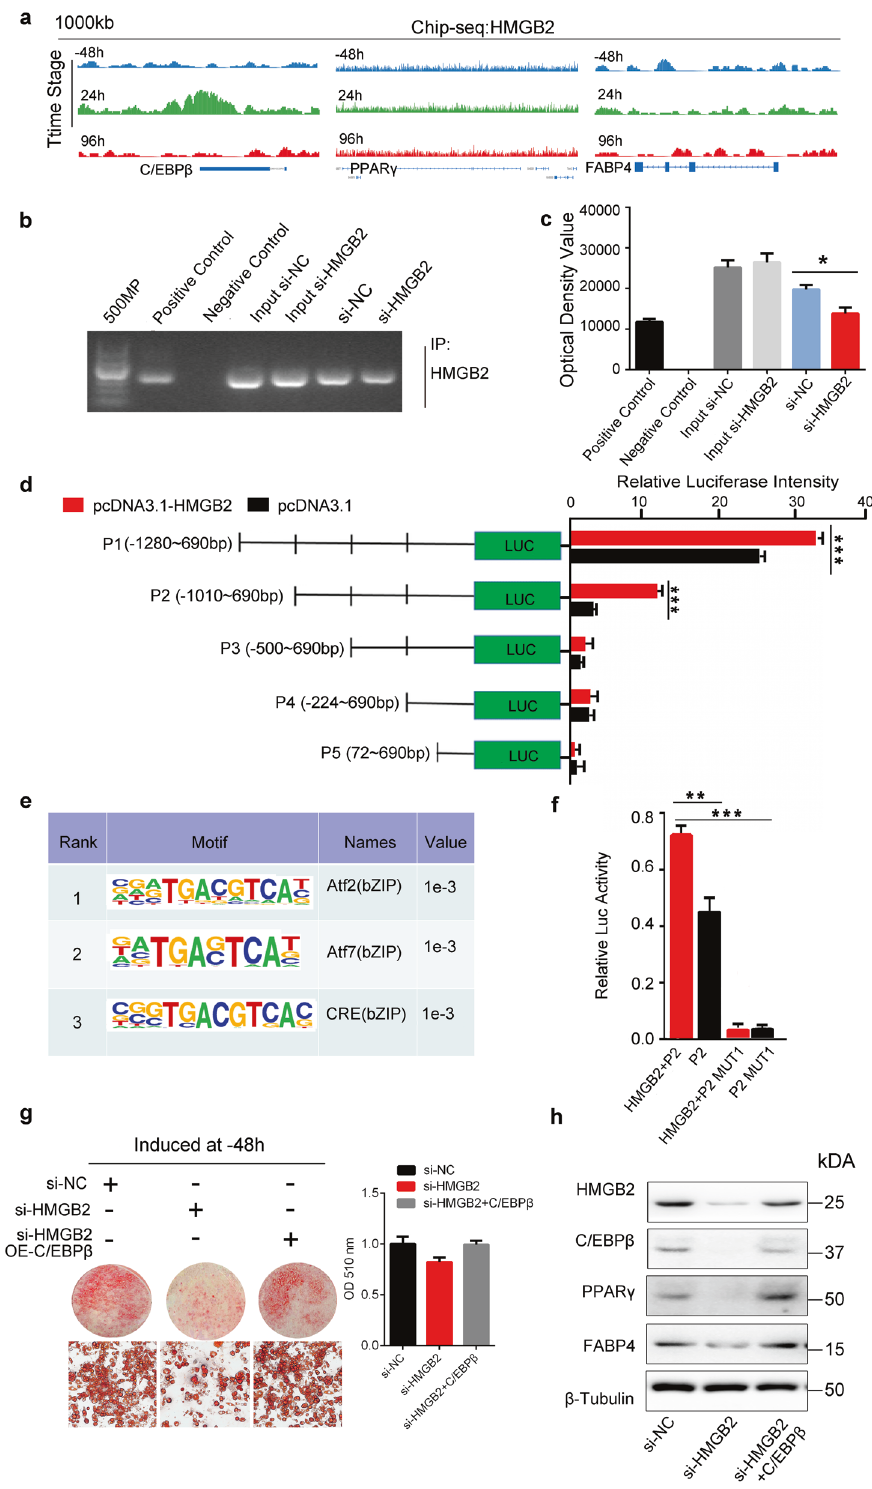
Fig. 6 HMGB2 binds to the promoter of C/EBP β in MCE stage to modulate adipogenesis. a ChIP-seq analysis of the peak distributions of C/ EBP β , PPAR γ , and FABP4 loci bound by HMGB2 at − 48, 24, and 96 h. b ChIP-PCR assay for the interaction between HMGB2 and C/EBP β promoter in 3T3-L1 cells. c Band intensity for b ( n = 3, * P < 0.05). d Luciferase activity for truncated DNA fragments of C/EBP β (*** P < 0.001). Experiments were conducted in 293T cells. e Binding motif of HMGB2 on C/EBP β . HOMER and KNOWN analysis by ChIP-seq on FDR-corrected, p values represent enrichment. f Luciferase activity of potential regions of C/EBP β bound by HMGB2 before and after mutation (*** P < 0.001). Experiments were carried out in 293T cells. g Oil Red-O staining assay in 3T3-L1 cells (left) and OD measurements (right). h Western blot for adipogenic genes. ( g , h : 3T3-L1 cells transfected with si-NC, si-HMGB2, and si-HMGB2 with C/EBP β overexpression plasmid, respectively).